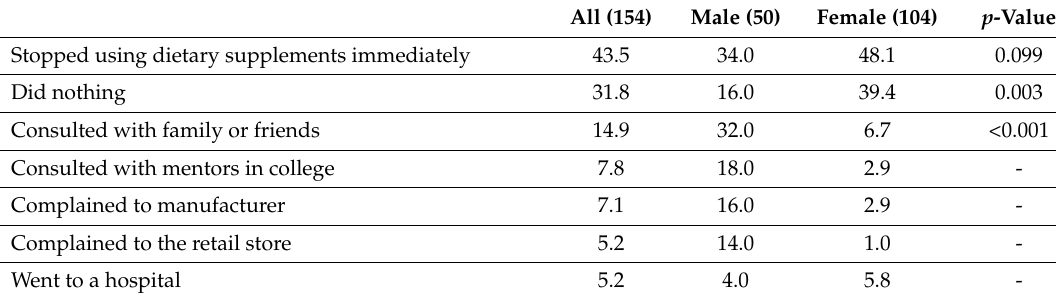
Table 8. How did you responses to the adverse effects?